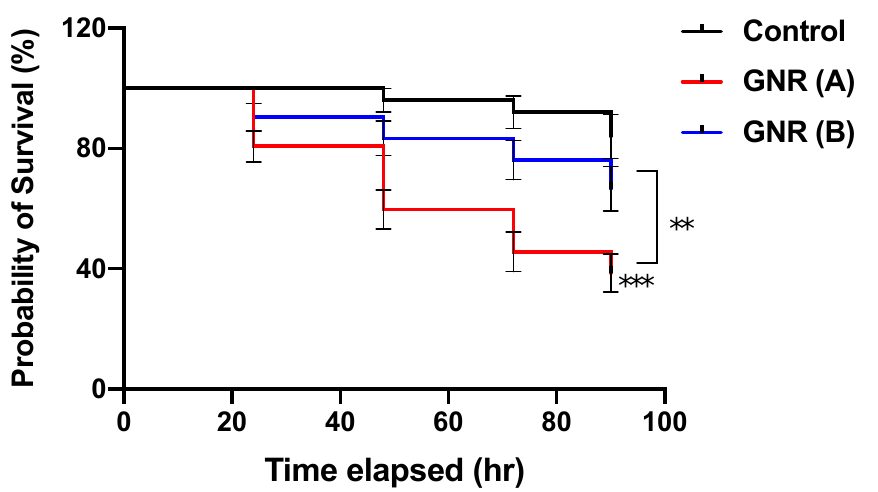
Figure 2. Kaplan Meier survival curves of embryos treated with GNR (A) and GNR (B) compared to the control. GNR (A)-exposed embryos exhibit significantly lower survival events than GNR (B)-treated embryos and control. ** p < 0.01, *** p < 0.001.